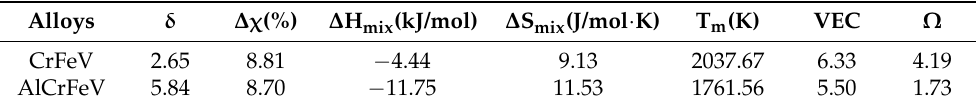
Table 2. Certain geometric and thermodynamic parameters of CrFeV and AlCrFeV multi- component